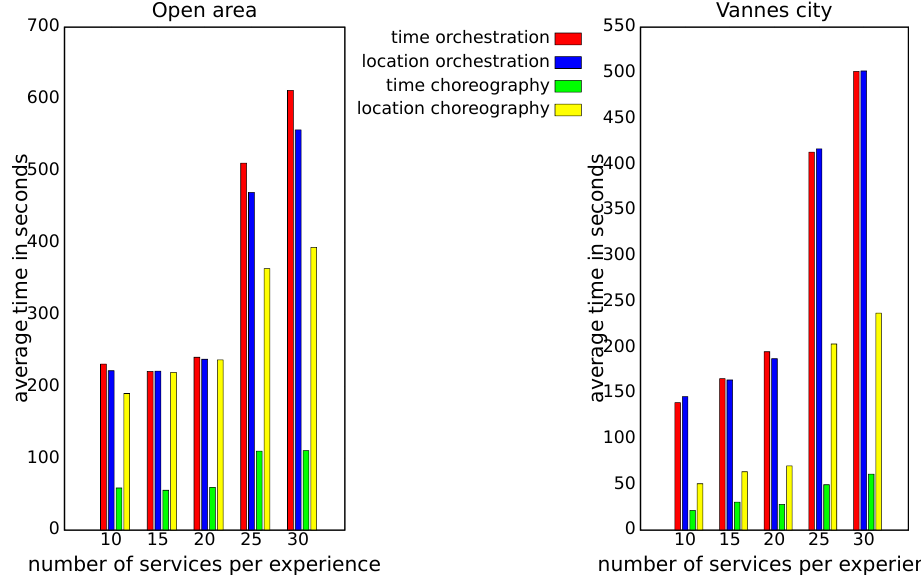
Figure 9. Average of invocation time against number of services per